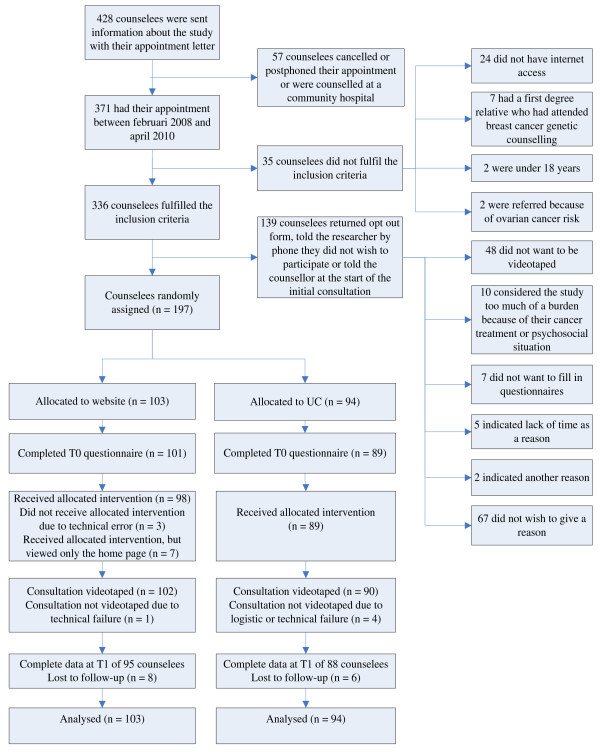
Flow diagram of study participants.